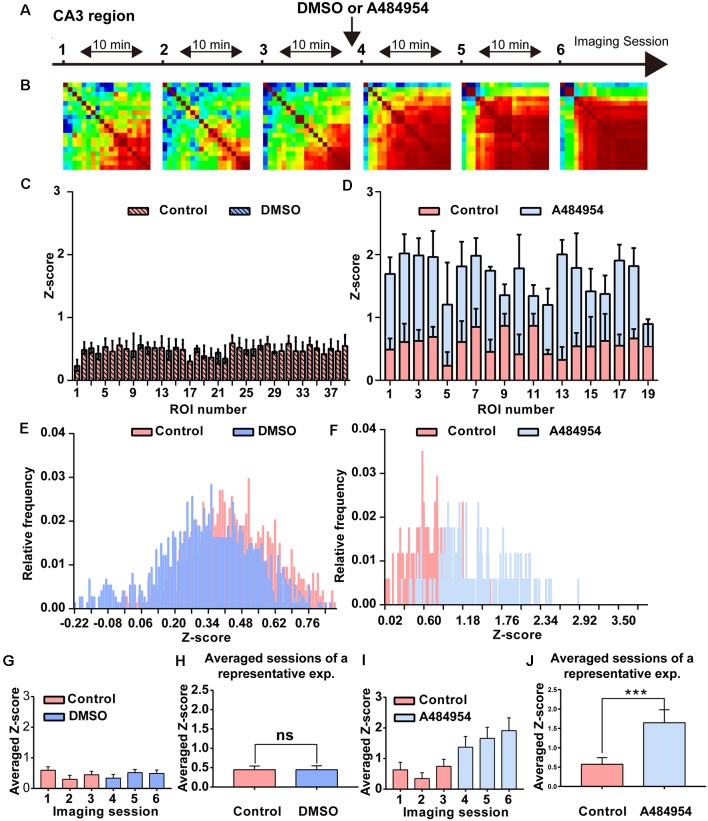
Detailed analysis of a time-lapse imaging experiment in the CA3 region under control–DMSO or control–A484954 conditions. (A) The schema indicates the sequence or time-lapse imaging session. The first three sessions were under control conditions, and the last three sessions under DMSO or A484954. (B) Heat maps (color-coded PC values per pair of ROIs) have been presented for the six sessions. The increase in red color indicates an enhancement of synchronized fluorescence transients after A484954 application. (C) The bar graph summarizes the individual Z scores for over 30 neuronal pairs for the two indicated conditions. The data indicated that DMSO did not affect the level of synchronization. (D) The level of synchronicity increased substantially after application of A484954 in comparison with the control sessions. (E) The frequency histograms for the Z scores of a control and DMSO session are presented. Only a slight shift to the left was observable after DMSO application. (F) After application of A484954, the Z score distribution shifted to the right, indicating a higher level of synchronicity within different CA3 areas. (G) The bar graph shows the averaged Z score over all ROI pairs for every session (session 1, 0.60 ± 0.11; session 2, 0.30 ± 0.13; session 3, 0.45 ± 0.11; session 4, 0.34 ± 0.12; session 5, 0.52 ± 0.10; session 6, 0.49 ± 0.12). (H) The values for the control–drug experiment are presented. After application of A484954, a tendency of increased Z scores was notable (session 1, 0.63 ± 0.25; session 2, 0.34 ± 0.19; session 3, 0.75 ± 0.22; session 4, 1.37 ± 0.35; session 5, 1.66 ± 0.36; session 6, 1.91 ± 0.42). (I) The bar graph shows the Z score-transformed PC values for each session under control and DMSO conditions (control: 0.45 ± 0.10; DMSO: 0.44 ± 0.11, ns, paired t-test). (J) The bar graph shows the values for three averaged sessions under control–A484954 conditions (control: 0.5 ± 1.64; A484954: 1.64 ± 0.33; ***P < 0.01, paired t-test).